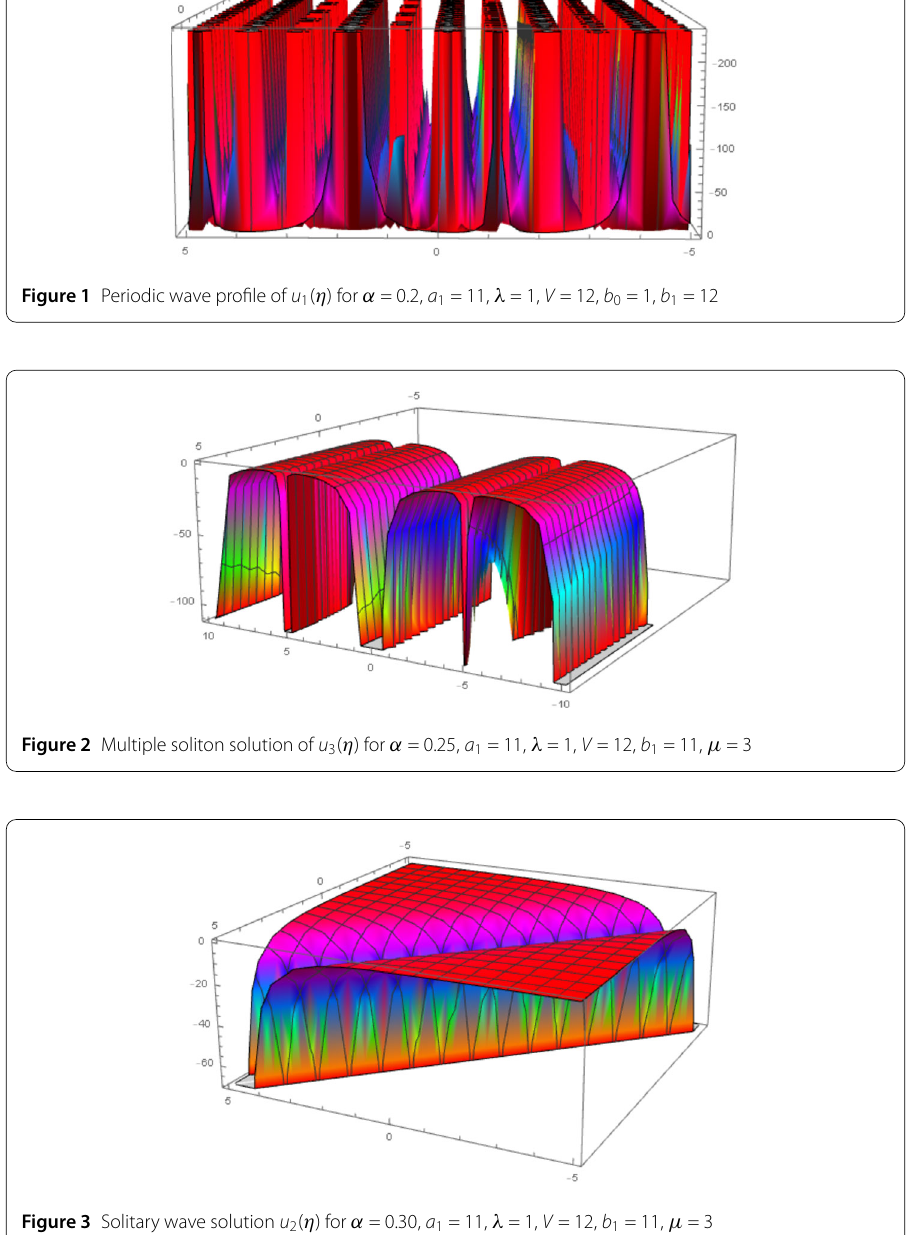
Again the solitary wave solution of u 4 ( η ) for α = 0.75, a 1 = 1, λ = –1, V = 0, b 1 = 1 is ob- tained in Fig. 4. Figures 5 and 6 represent soliton solutions of u 4 ( η ) and u 14 ( η ) for different values of parameters. Solitons are special types of solitary waves that retain the identity upon interaction with other solitons and have implications in the field of cosmology of the universe. Figure 7 shows the kink wave solution of u 9 ( η ) for α = 0.30, a 1 = 11, λ = 0.77, b 0 = 1, V = 10, b 1 = 100. The kink waves are the solitary waves that are rise or descend from one asymptote state to another. Figure 8 displays the periodic solution of u 12 ( η ) for α = 0.9, a λ = –100, b 1 = 11, 0 = 1, V = 10. The periodic solutions are traveling wave